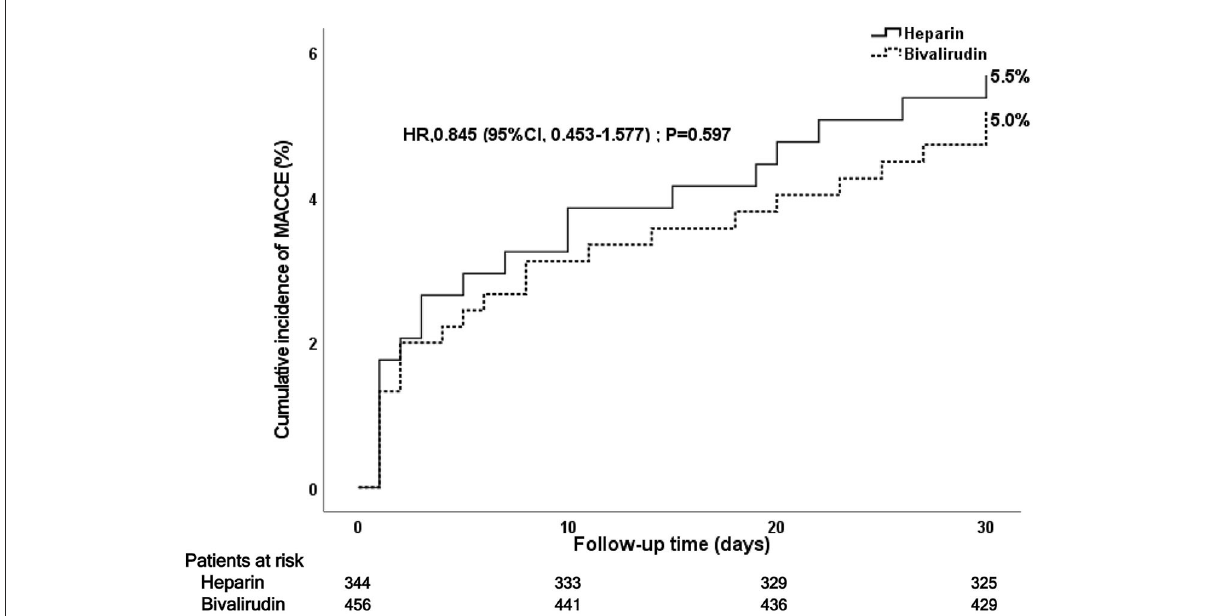
FIGURE3 Kaplan–Meier curve of post-PCI 30-day MACCE. PCI, percutaneous coronary intervention; MACCE, major adverse cardiac and cerebrovascular events.